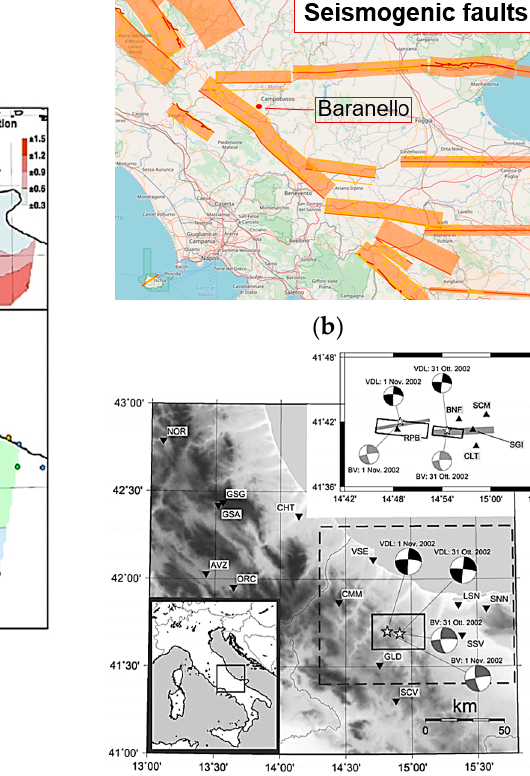
Figure 3. Historical earthquakes in the inspected area [24].